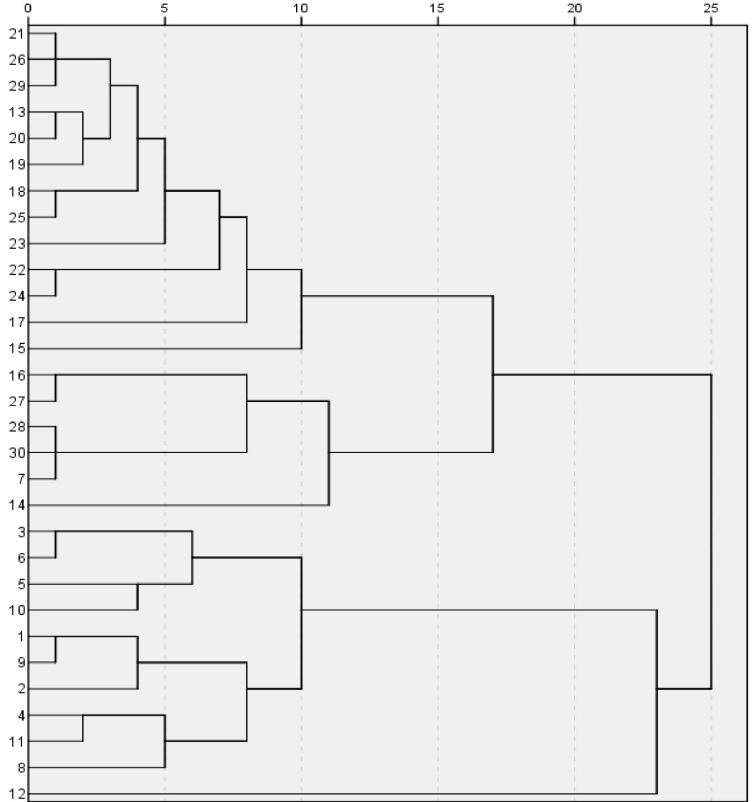
Figure 6. Q mode HCA of Yanbu seawater samples . Table 5. Principal component loadings and variance percentage for the five components .